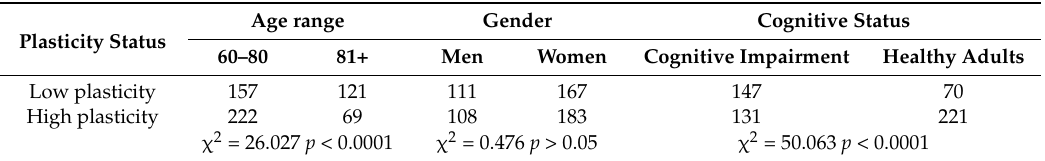
Table 1. Mean scores and differences as a function of the variables analyzed in all Auditory Verbal Learning Test—Learning Potential (AVLT-LP) test trials and in AVLT-LP gain score.